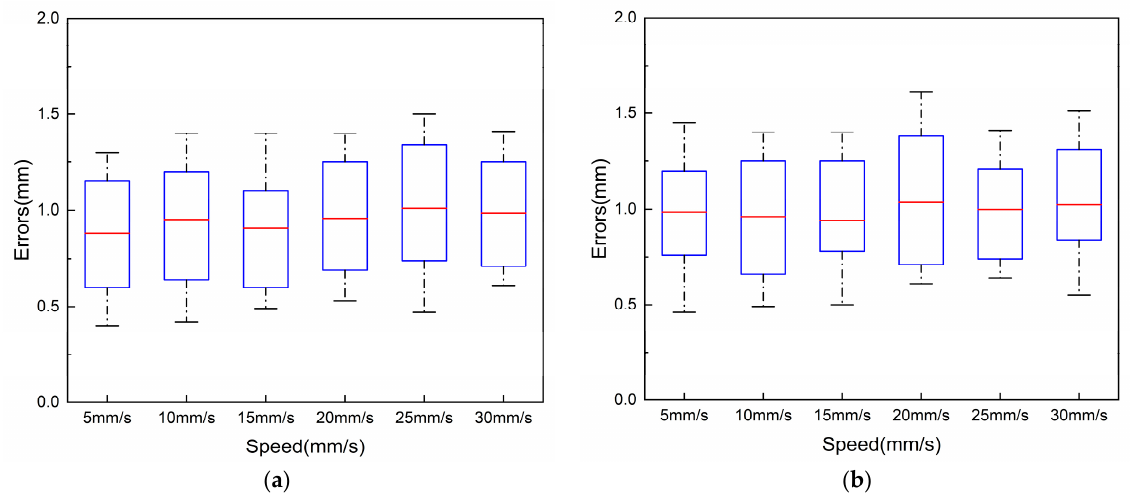
Figure 15. ( a ) Axial catheter delivery error. ( b ) Axial guidewire delivery